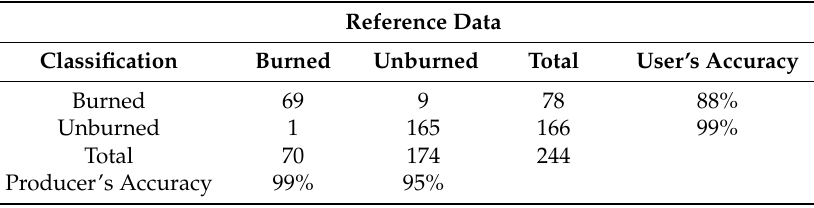
Table 2. Confusion matrix for the burn classification